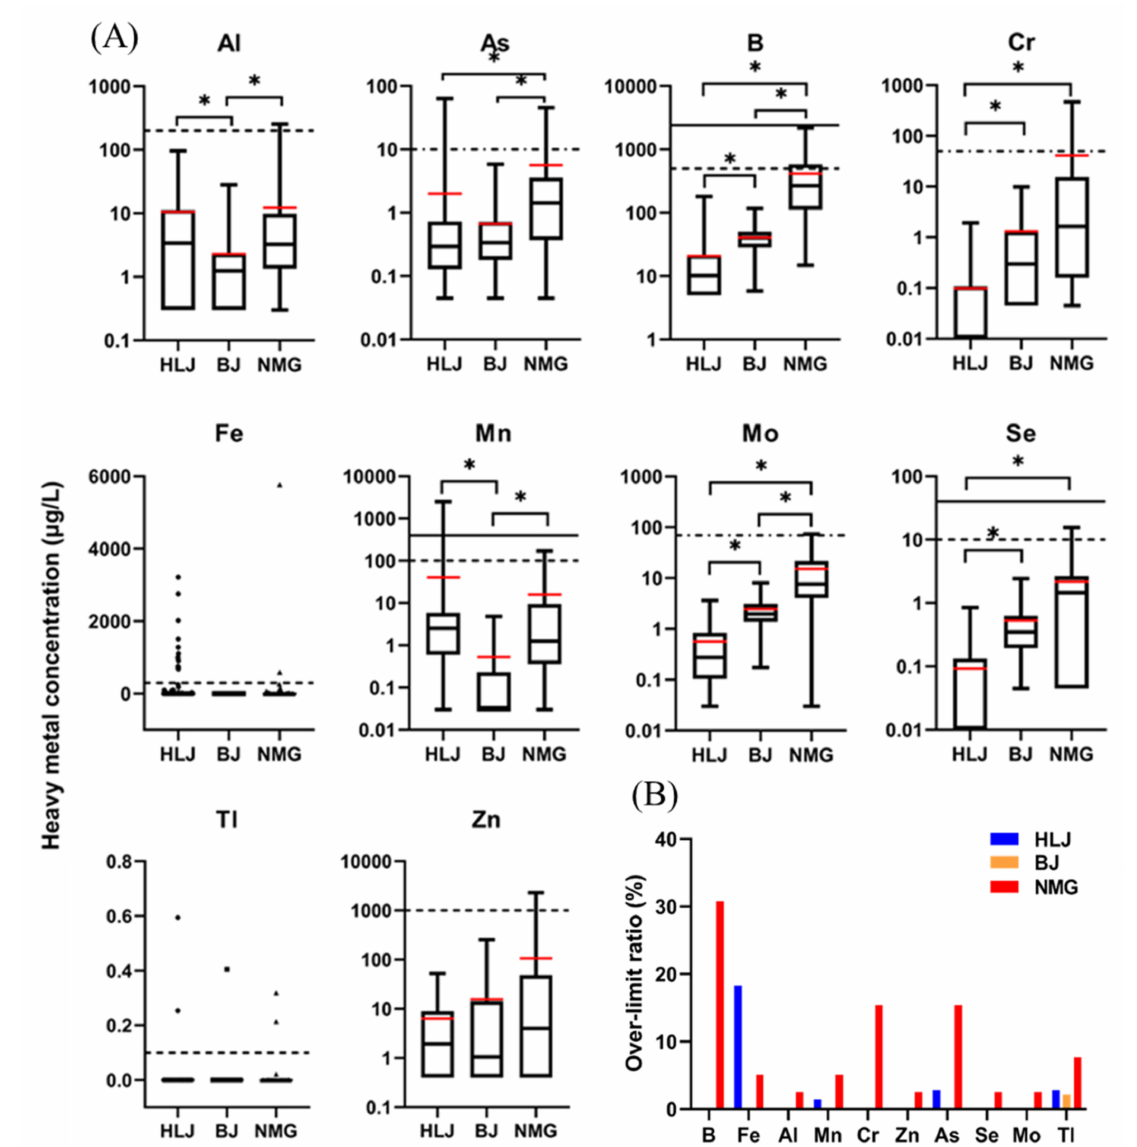
Figure 3. The concentrations of heavy metals in self-supplied wells water. ( A ) Heavy-metals concen- tration (elements mentioned and exceeding in SDW or WHO). Straight line, WHO; dotted line, SDW; dash-dotted line, SDW and WHO have the same standards limits. The red line is the average value. ( B ) The over-limit ratio of heavy metals. * Represents p <